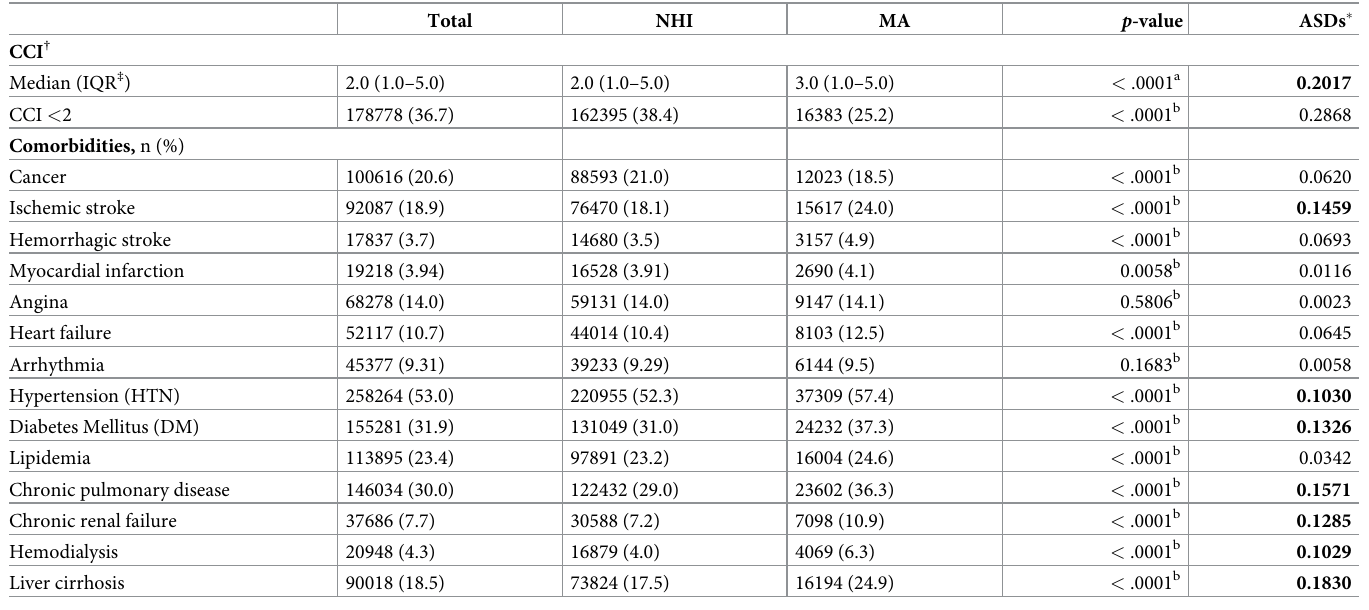
Table 2. Comorbidities in national health insurance group and medical aid group.